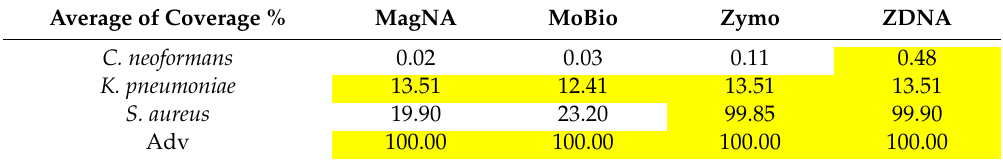
Table 5. Average coverage percentage (coverage %) from DNA sequencing for the pathogens included in the mock sample using di ff erent protocols. Average of Coverage